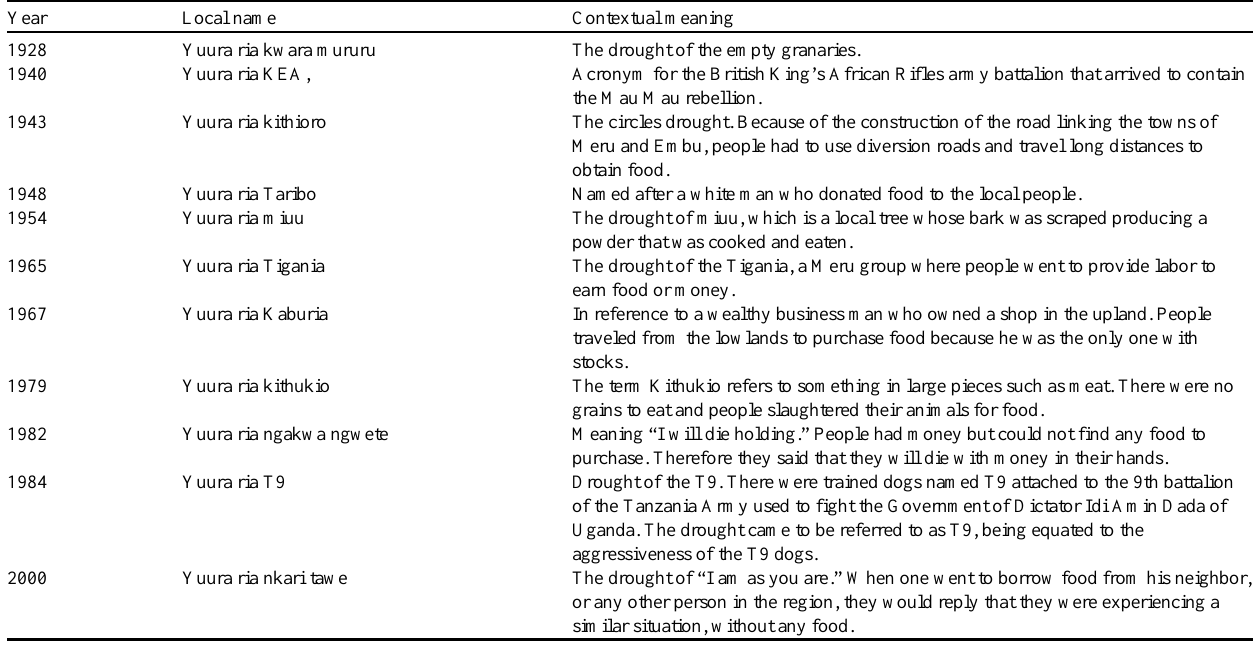
Table 3 . Meru drought nomenclature and contextual